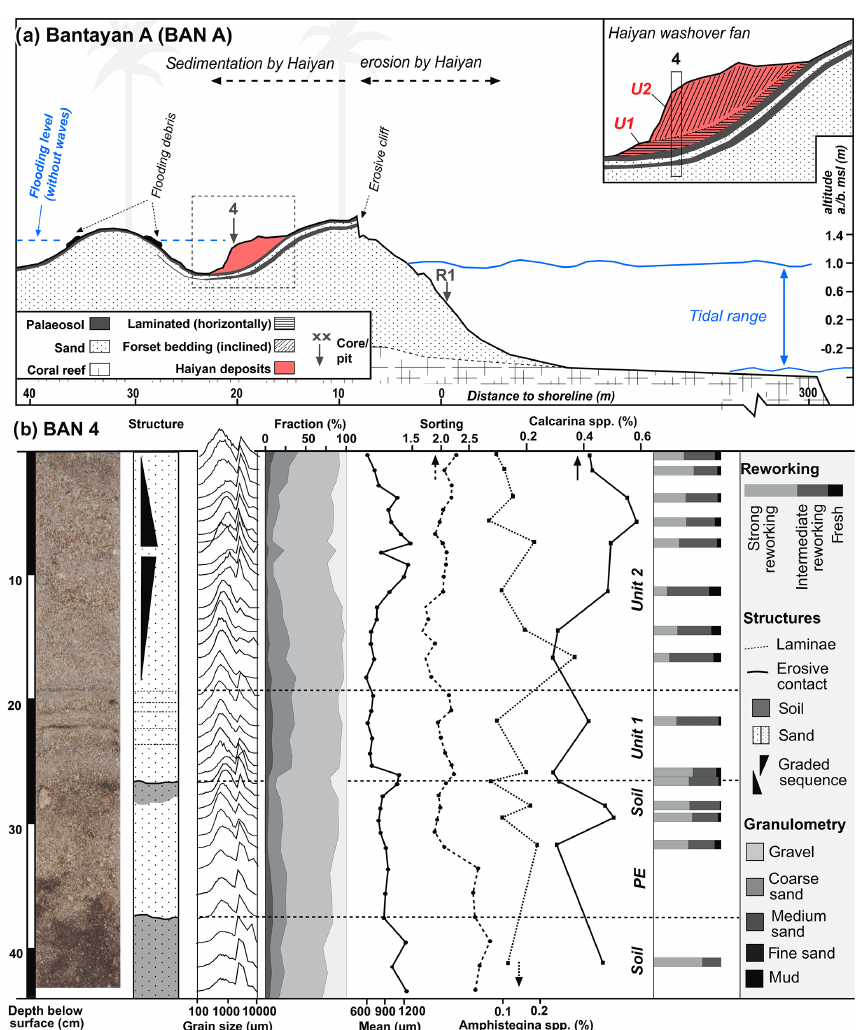
Figure 12. Typhoon Haiyan onshore deposits at site BAN A. (a) A shore-perpendicular cross section (see Fig. 11 for location) reveals two sedimentary units within the washover fans: a flat and planar laminated unit at the base (U1) and steep, landward-inclined lobes on top (U2). Below the pre-Haiyan soil, a second palaeosol is covered by a thin sand layer (PE), possibly a former extreme wave event. (b) Sedimentary characteristics of core BAN 4. The 26cm thick Haiyan deposits are clearly separated from older sediments by an initial soil formation. While the basal unit 1 is laminated, unit 2 is characterized by gradual coarsening, changing foraminifer composition (more Calcarina spp., less Amphistegina spp.) and a decreasing percentage of fresh foraminifer tests towards the